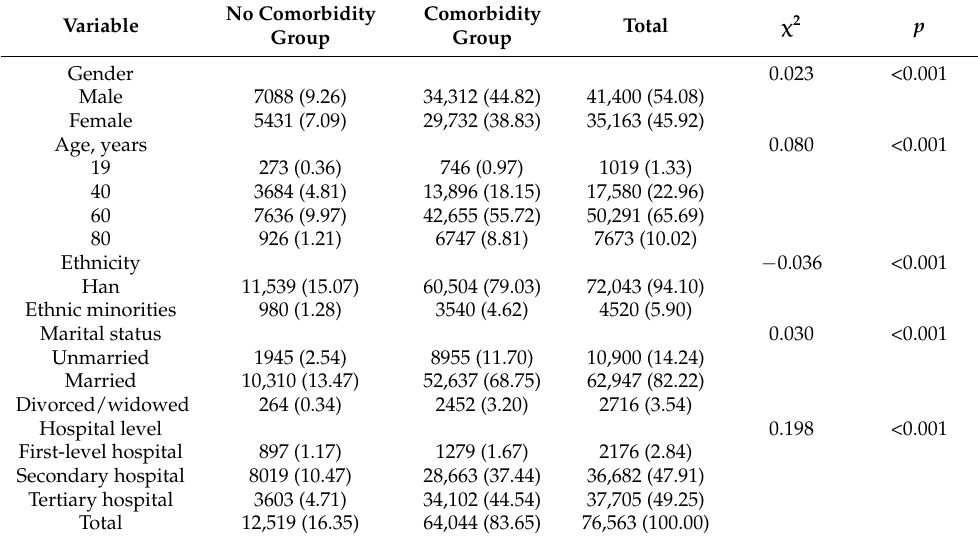
Table 1. Sociodemographic characteristics of discharged patients with cerebral infarction ( n (%)). No Comorbidity Comorbidity Variable Group